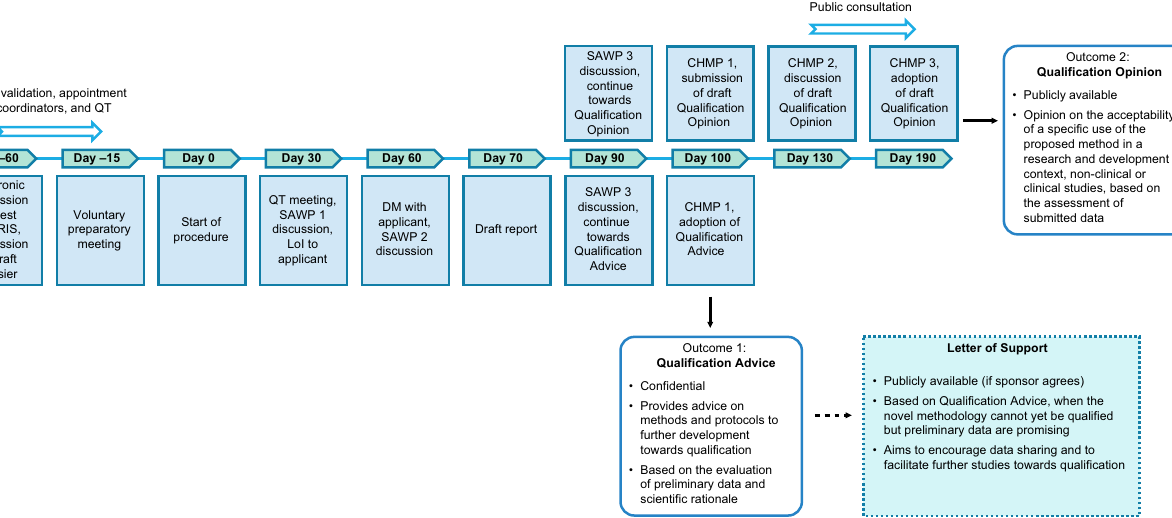
Fig. 2 Summary of the EMA quali fi cation procedure for digital technology-based methodologies to support approval of medicinal products. Procedure summary for the quali fi cation for digital technology-based methodologies to support the approval of medicinal products, including the potential application outcomes. CHMP Committee for Medicinal Products for Human Use, DM discussion meeting, EMA European Medicines Agency, LoI List of Issues, QT quali fi cation team, SAWP scienti fi c advice working